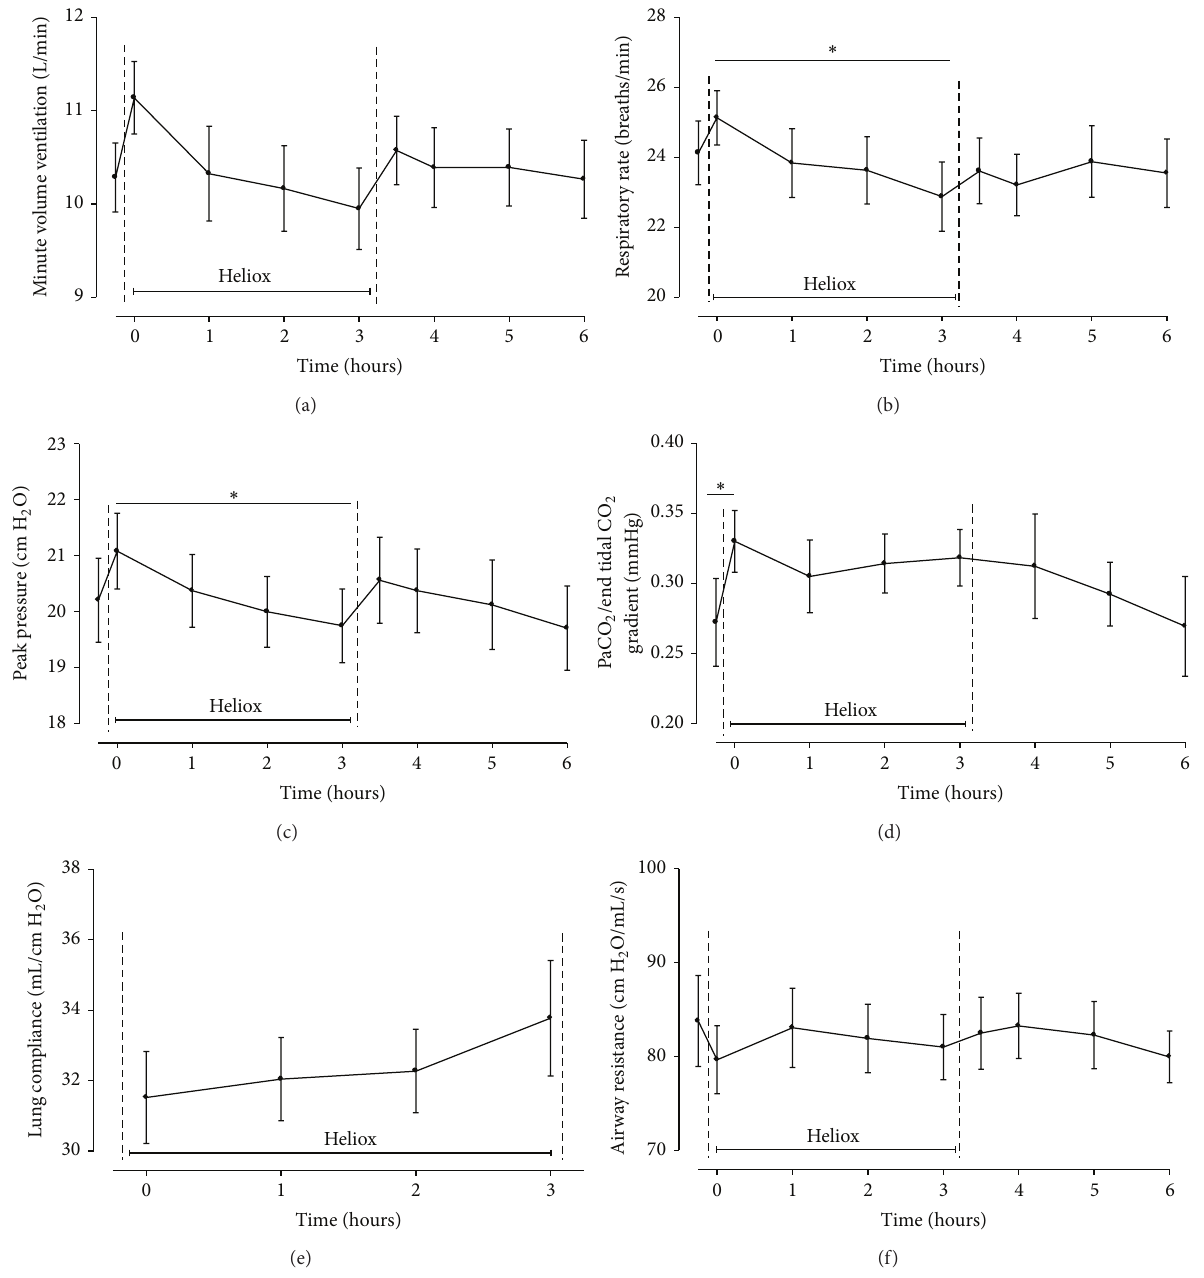
Figure 1: Respiratory parameters during heliox ventilation for 3 hours ( 𝑇 = 0 to 𝑇 = 3 ) and after switch to normal oxygen in air mixture ( 𝑇3 to 𝑇6 ). Measurements started prior to heliox administration ( 𝑇 = −1 ). Data are means ± SEM. (a) Minute volume ventilation (Lmin −1 ); (b) respiratory rate (breaths min −1 ); (c) peak pressure (cm H 2 O); (d) PaCO 2 /end tidal CO 2 gradient (mmHg); (e) airway resistance (cm H 2 O mL −1 sec −1 ); and (f) lung compliance (mLcm −1 H 2 O). ∗ : 𝑃 < 0.02